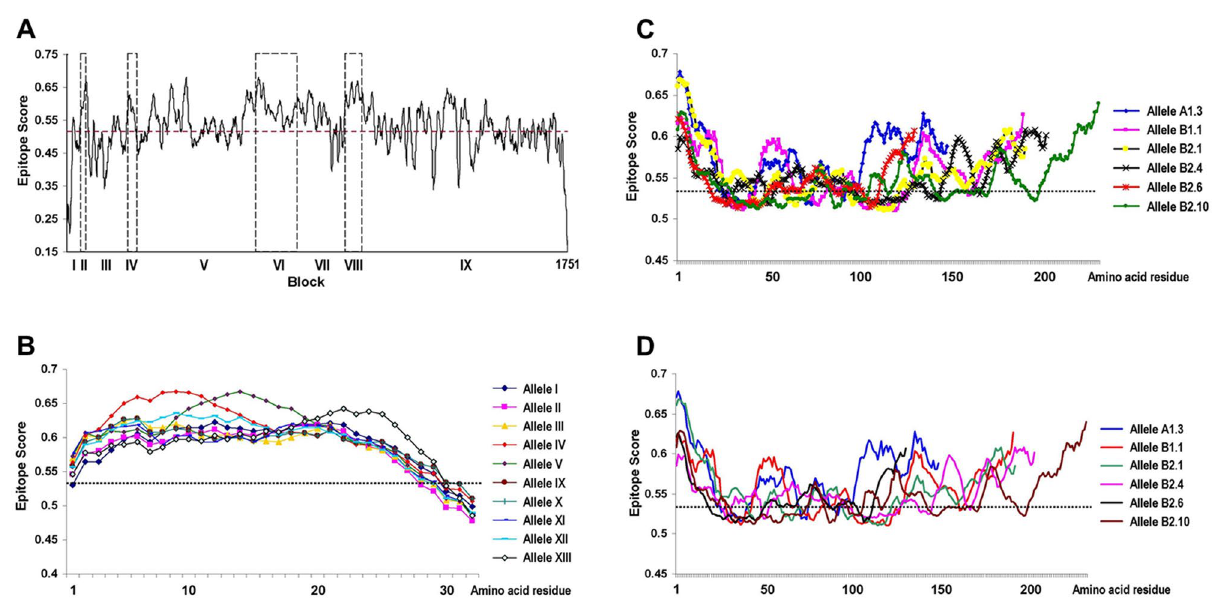
Figure 5. Predicted linear B-cell epitopes in PmMSP1 based on the BepiPred 2.0 method. ( A ) Epitope scores across the entire protein (GenBank accession no. FJ824669). Variable blocks are shown as broken boxes. ( B – D ) represent epitope scores for representative alleles of blocks IV, VI and VIII, respectively. The cutoff value is indicated by a broken